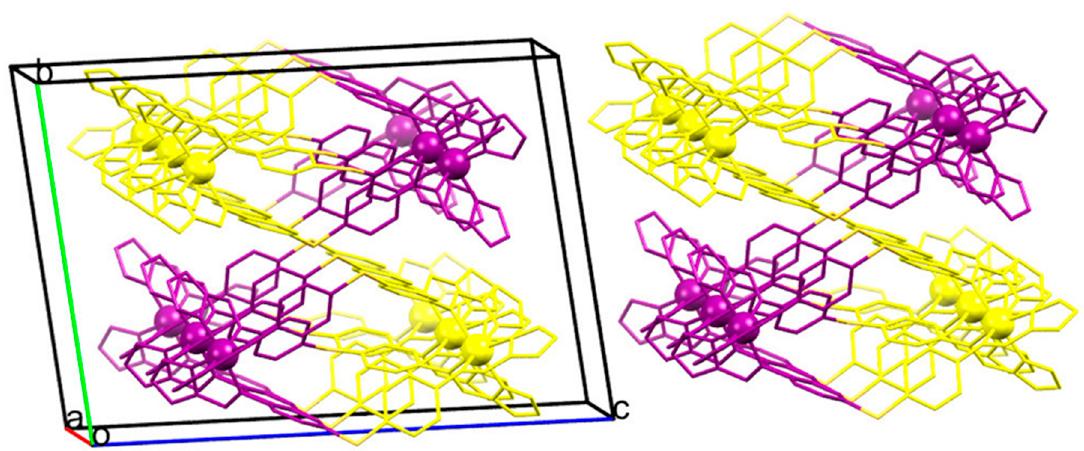
Figure 6. Schematic representation of the X-ray crystal structure of 2 at 100 K showing the distribution of high (yellow) and low spin (purple) Fe(II) centres in alternating HS and LS centres along the b - and c -axis, and in chains of the same spin state along the a -axis. Hydrogens, solvent and counter ions have been excluded for clarity.